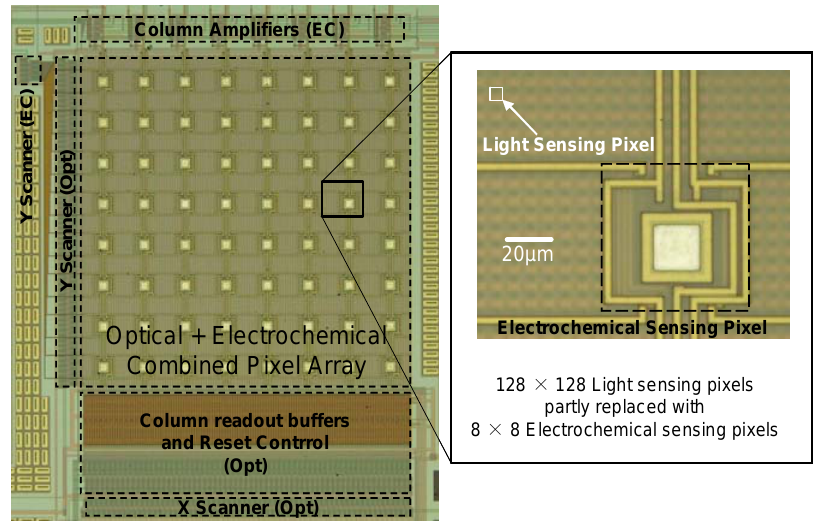
Figure 7. Layout of the optical and active electric (conductive coupling) dual-image CMOS sensor (adapted from [4]).